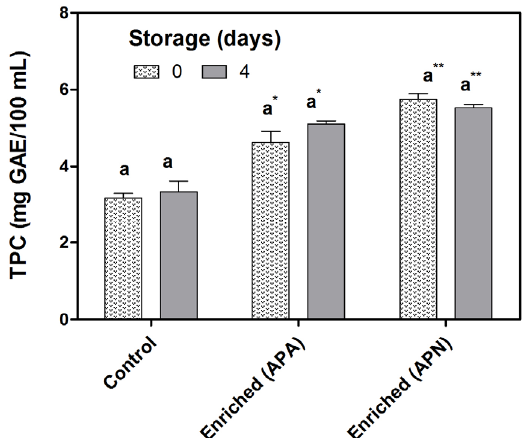
Figure 2. Total phenolic content of tomato juice with added phenolic extracts (neutral APN; or acidic APA) compared to control at time 0 and after four days of storage. Different letters within the same type of juice indicate significant differences between storage times ( p < 0.05). An asterisk indicates a significant difference between the enriched sample (APA) and the control sample at the same storage time; a double asterisk indicates a significant difference between the enriched sample (APN) and the control at the same storage time. TPC, total phenolic content; GAE, gallic acid equivalents.